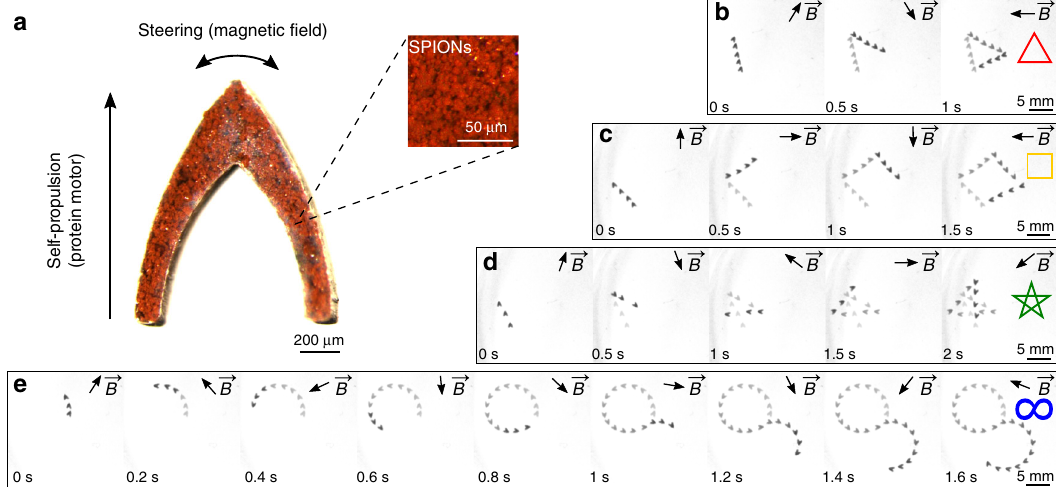
Fig. 3 Locomotion trajectory control of protein motors ( l = 1 mm) via active magnetic steering. a Magnetic motors (SPION and protein nanocomposite) are self-propelled by the protein motor and steered by a magnetic fi eld. Complex 2D motion trajectories: ( b ) triangle, ( c ) square, ( d ) pentagram, and ( e ) lemniscate trajectories were programmed and de fi ned by a variable magnetic fi eld ~ B . Arrows show the direction of the magnetic fi eld ~ B